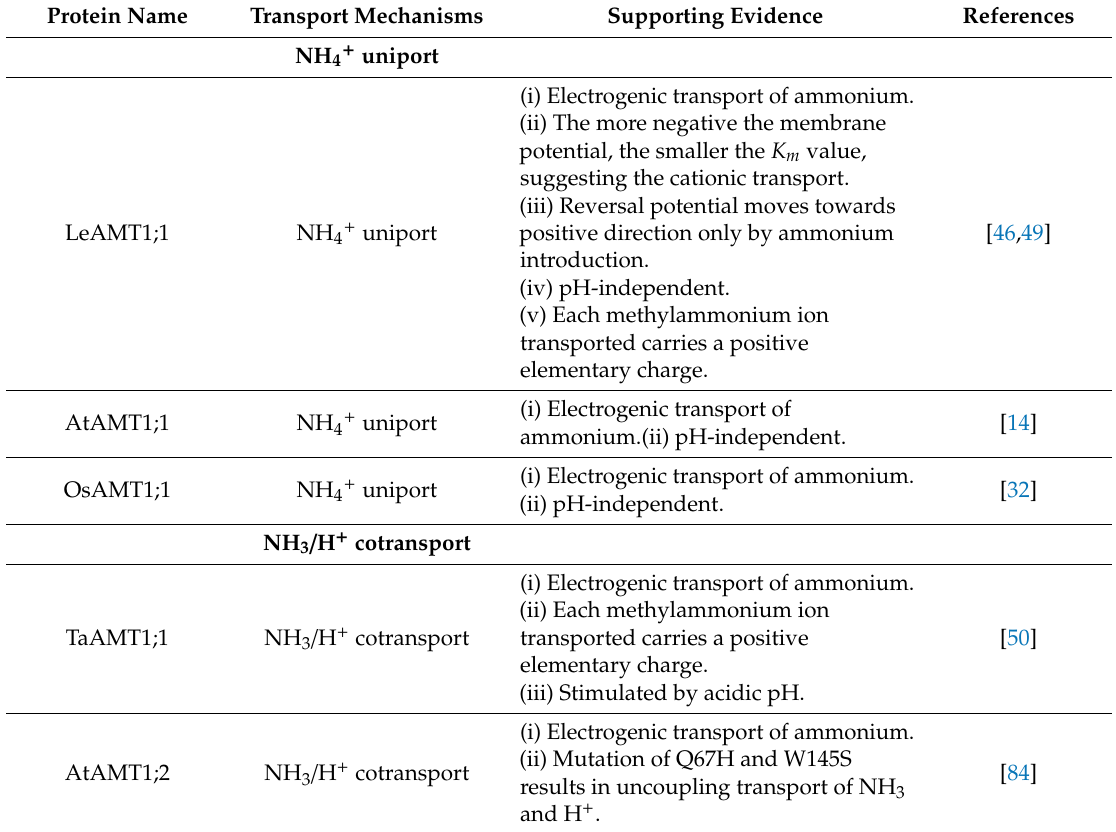
Table 2. Transport mechanisms of plant